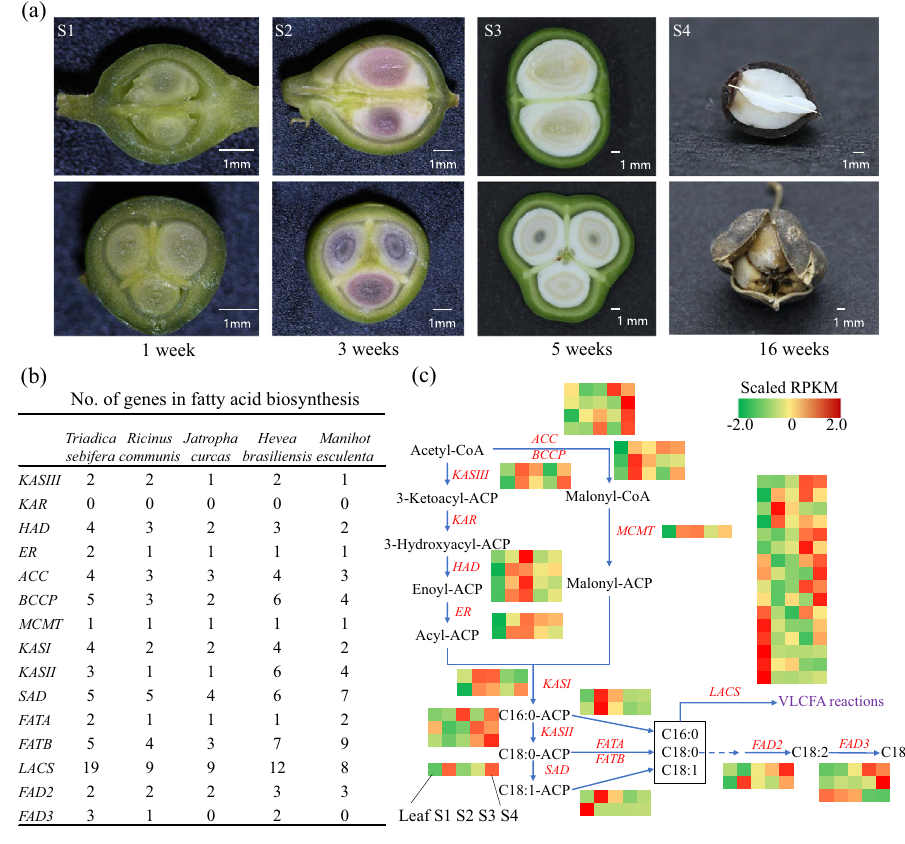
Fig. 4 Analysis of fatty acid (FA) biosynthesis genes in the Chinese tallow tree (CTT) genome. a The development of CTT seeds. S1 to S4 indicate 1, 3, 5, and 16 weeks after pollination (WAP), respectively. The upper panels indicate transverse cross sections of CTT seeds in different developmental stages, while the bottom panels indicate the longitudinal sections of CTT seeds. b Numbers of genes involved in fatty acid biosynthesis for fi ve plants in the Euphorbiaceae family. The monoploid genome sequence was used to perform this analysis. c Gene expression patterns of FA biosynthesis genes in leaves and S1 to S4 developmental stages. The fi ve boxes with different colors indicate these fi ve samples. Scaled reads per kilobase per million mapped reads (RPKM) values were used for the heat plot. KASIII β -ketoacyl-acyl carrier protein synthase-III, KAR 3-ketoacyl-acyl carrier protein (ACP) reductase, HAD 3-hydroxyacyl-ACP dehydratase, ER enoyl-acyl carrier protein reductase, ACC acetyl- CoA carboxylase, BCCP biotin carboxyl carrier protein, MCMT malonyl-CoA ACP transferase, KASI β -ketoacyl-acyl carrier protein synthase-I, KASII β -ketoacyl-acyl carrier protein synthase-II, SAD stearoyl-ACP desaturase, FATA fatty acyl-ACP thioesterase A, FATB fatty acyl-ACP thioesterase B, LACS long-chain acyl-coenzyme A (CoA) synthetase, FAD2 fatty acid desaturase 2, FAD3 fatty acid desaturase